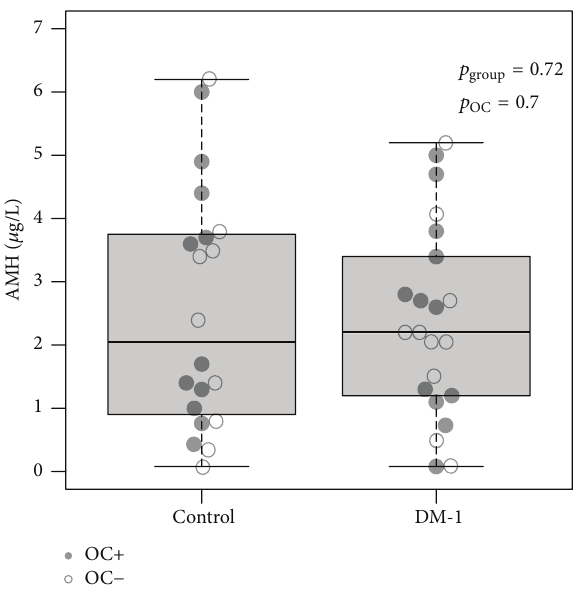
Figure 3: Boxplot of AMH levels for both study groups. AMH levels did not differ between patients and controls (𝑝 = 0.72 ) nor was there an effect of OC use (𝑝 = 0.70)